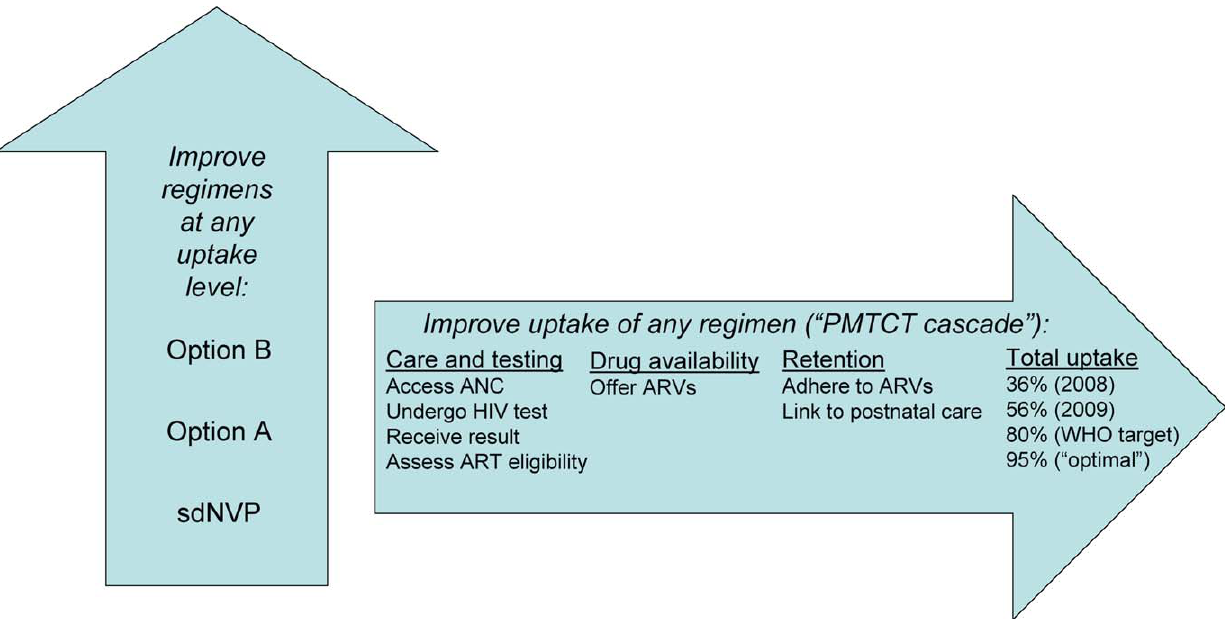
Figure 1. Two dimensions for potential improvements in PMTCT in Zimbabwe. This figure shows the ‘‘two dimensions’’ in which PMTCT services can be improved. First, along the vertical arrow, PMTCT programs can transition to more intensive drug regimens (i.e., from sdNVP to Option A to Option B). Second, along the horizontal arrow, programs can undertake interventions to improve ‘‘uptake’’ of PMTCT services, defined as the proportion of pregnant, HIV-infected women who receive and adhere to ARVs for PMTCT, for example, from 36% in 2008 to 56% in 2009, and perhaps to 80% or 95% with future scale-up effort. Within the horizontal arrow are depicted the three ‘‘domains’’ of uptake examined in these analyses: care and testing, drug availability, or retention. sdNVP represents the current National PMTCT Program, based largely on sdNVP; ‘‘Option A’’ and ‘‘Option B’’ are the WHO 2010 PMTCT guideline-recommended regimens, as defined in the text and Text S1. doi:10.1371/journal.pmed.1001156.g001 PLoS Medicine |